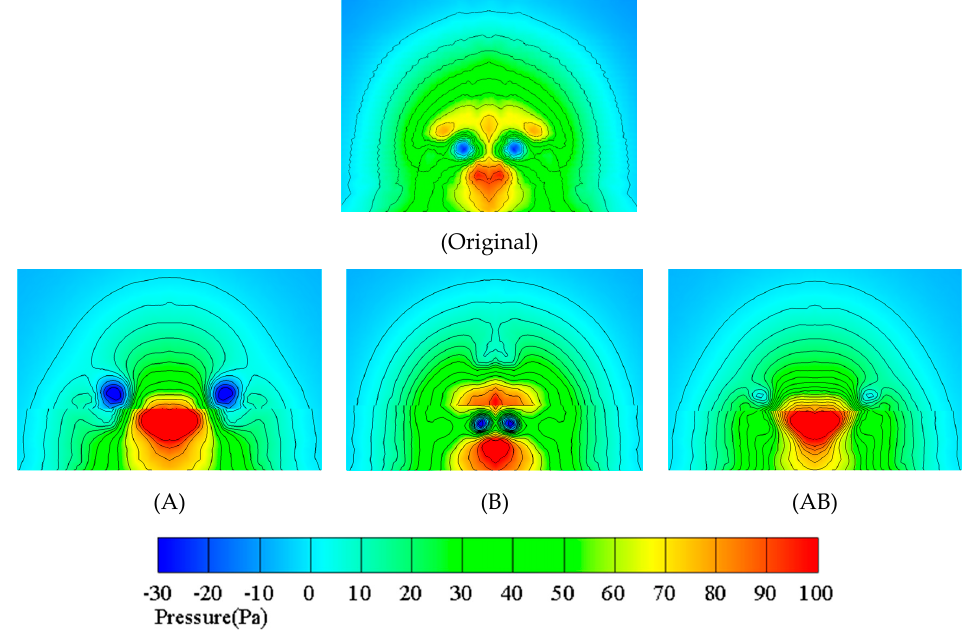
= 0.6 m section (15